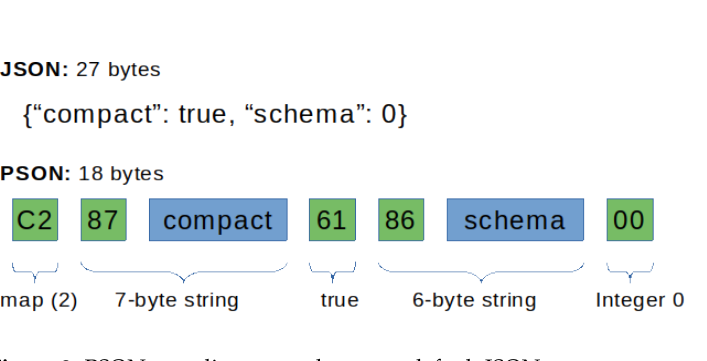
Figure 2. PSON encoding example versus default